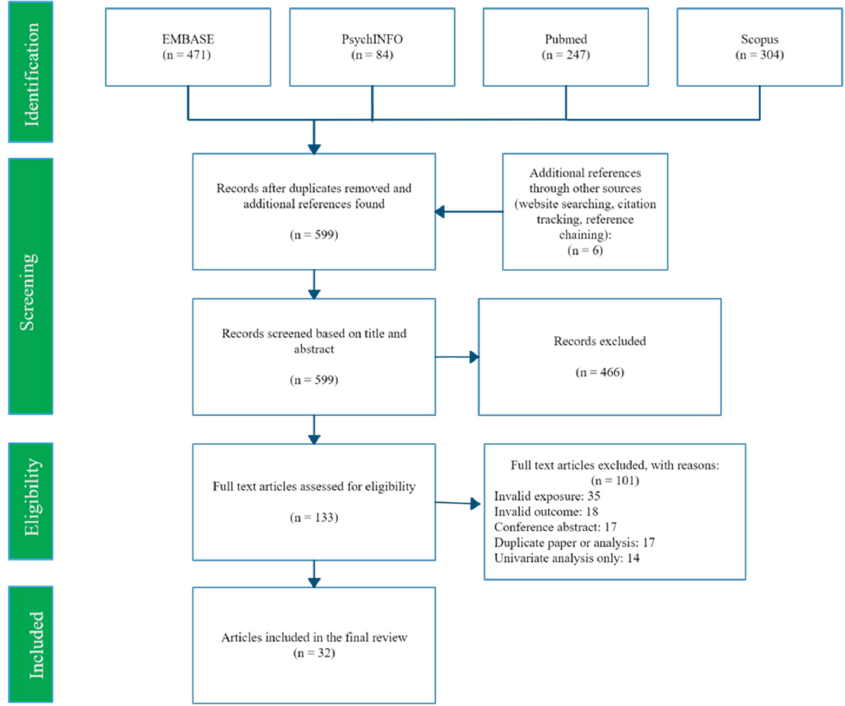
Figure 1. PRISMA flow diagram of search and selection process. Neurodevelopmental functioning was measured using 23 scales, and the most com- mon were variations of the BSID scale, found in 17 studies (Table 2). The BSID-II and Bay- ley-III) (also referred to as BSID-III) were designed to measure cognitive, motor, and lan- guage development in children aged 1 to 42 months. Scales are standardized across all ages to a mean of 100 and standard deviation of 15. The two versions are reviewed sepa- rately because performance on the two versions is correlated but not identical [42], and motor and language development is measured in a single scale in the second edition but not the third. Further scale details are available in Supplementary File Part 5. Table 2. Measures of neurodevelopmental functioning in the included studies. Abbreviation